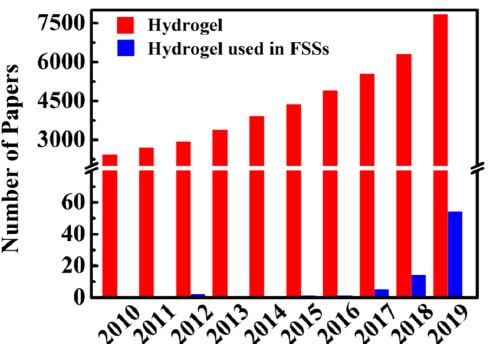
Figure 2. Number of published papers per year, by searching the topic “hydrogel”, “hydrogel” and “flexible strain sensor” from Web of Science in 05/2020.